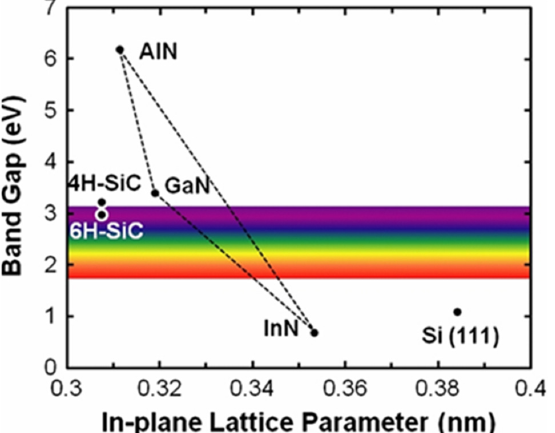
Figure 4. Lattice parameters and band gap for GaN-AlN-InN alloys [22]. (Data from [22]).